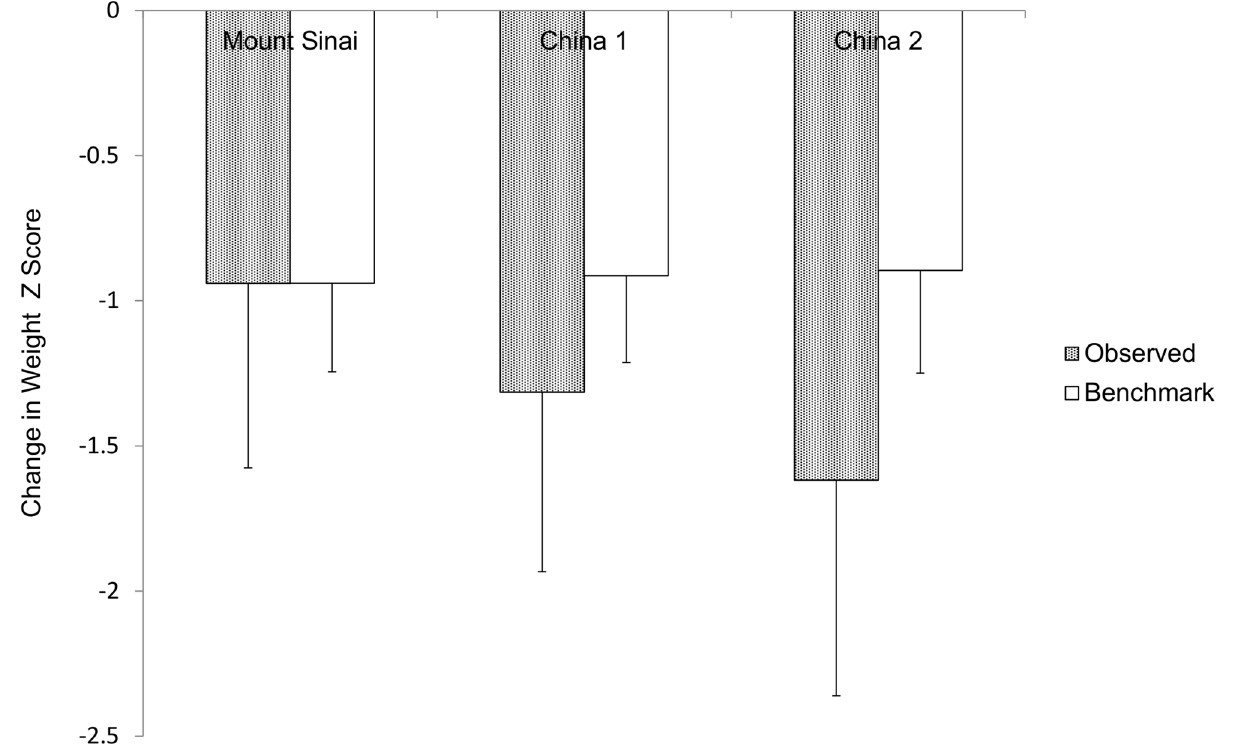
Fig 4. Observed and benchmark values of change in weight Z score from birth to discharge for the three NICUs. The benchmark values for the three NICUs do not differ significantly (p > 0.05). The observed values for the two Chinese NICUs differ from that of Mount Sinai, from each other, and from their benchmark values (p < 0.001 for all the comparisons). Per model design, the observed and benchmark values are the same for the Mount Sinai NICU.